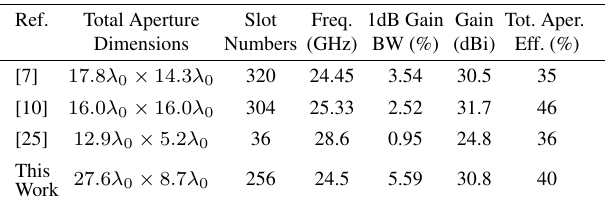
TABLE II. Comparison of the proposed antenna with previous studies.